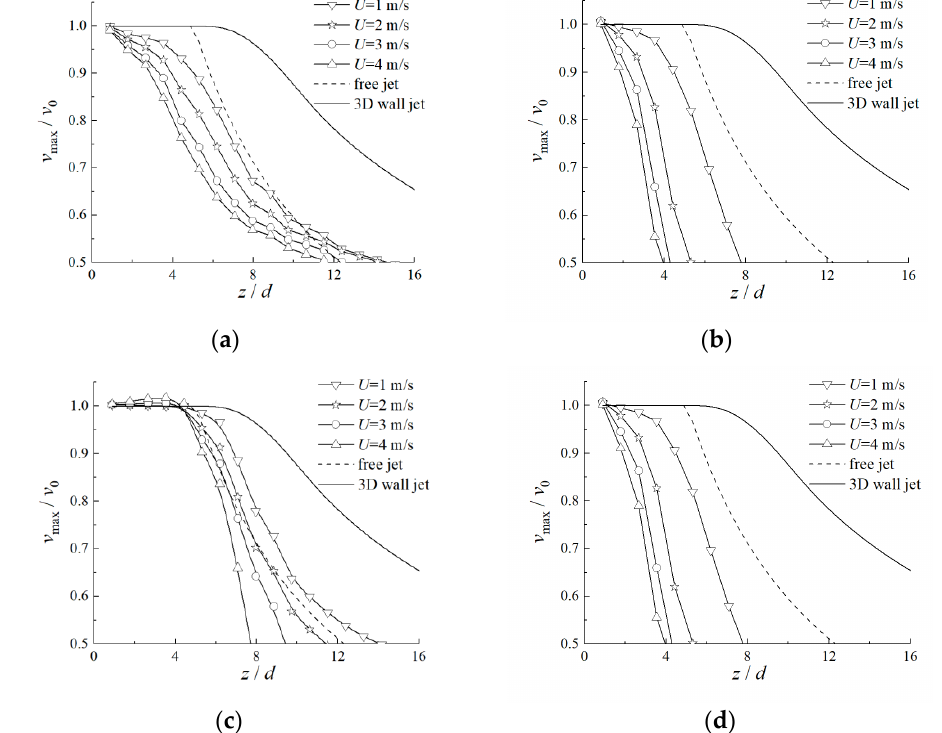
Figure 16. Axial velocity attenuation of the horizontal discharge jet under different U : ( a ) horizontal outlet 1; ( b ) horizontal outlet 2; ( c ) horizontal outlet 3; ( d ) horizontal outlet 4.